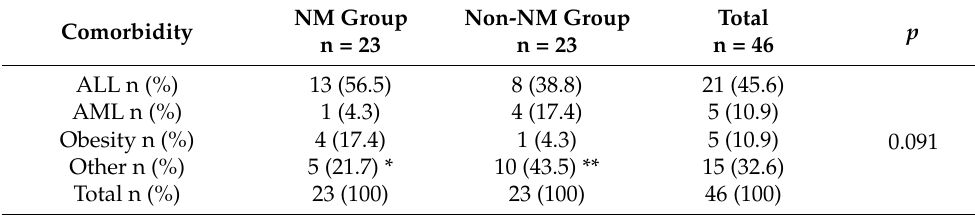
Table 2. Distribution of the comorbidities in pediatric patients with COVID-19.